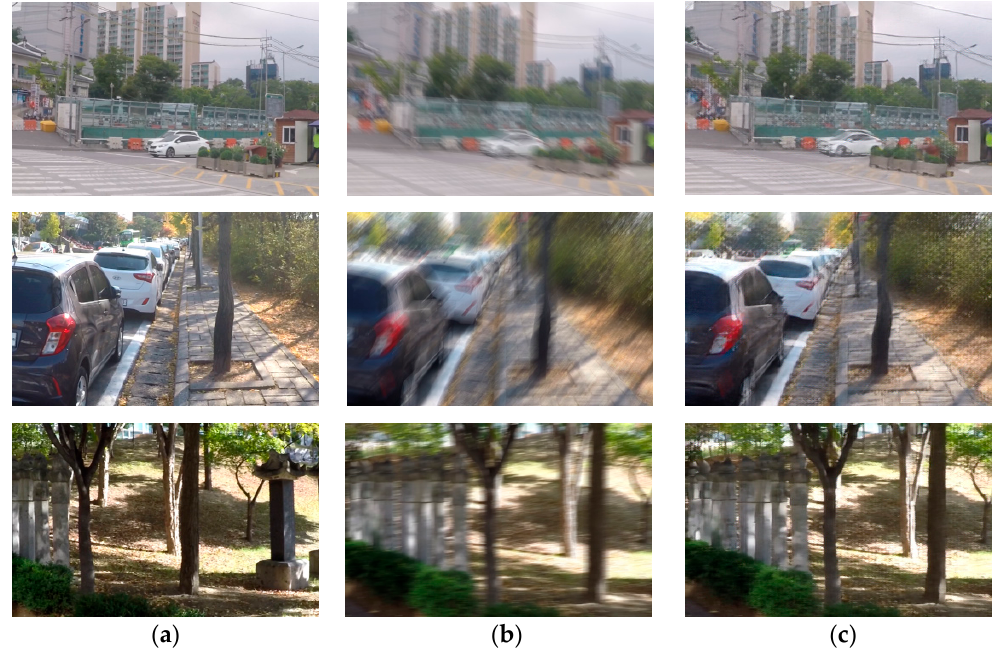
Figure 8. Example images of WGAN-GP with content loss function: ( a ) Sharp image. ( b ) Blurred image ( c ) Reconstruct image. Appl. Sci. 2019 , 9 , x FOR PEER REVIEW